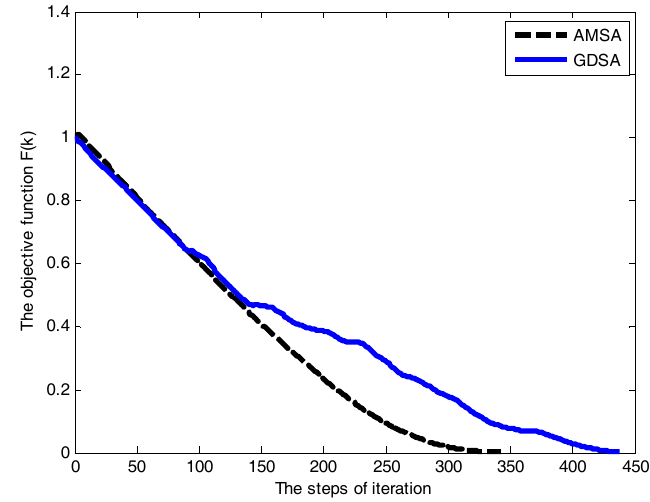
Figure 10. The convergence curves of the objective function.